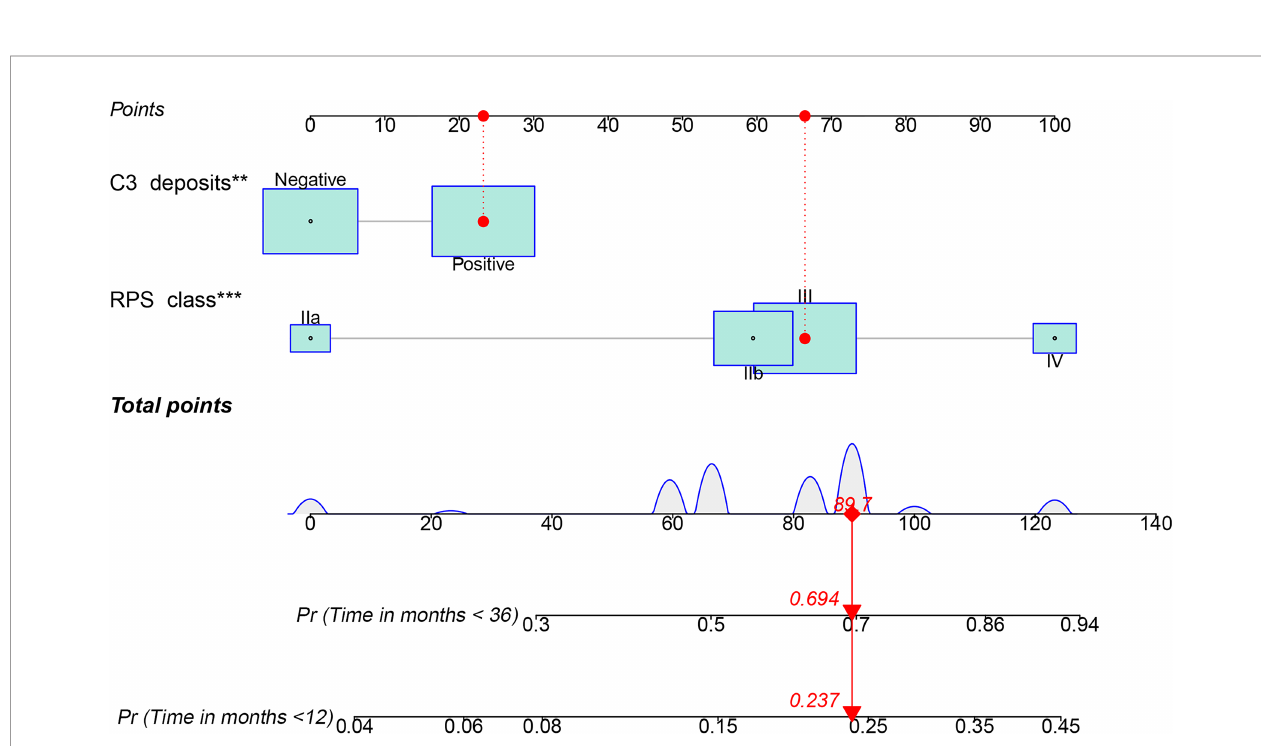
FIGURE 4 | Nomogram predicting the occurrence of a composite of end-stage renal disease, ≥ 50% decline in initial estimated glomerular fi ltration rate, or death according to the combination of C3 deposits and RPS class. PRS, Renal Pathology Society; ** p < 0.01; *** p < 0.001. C3 positive, 23.2 points; IIb, 59.5 points; III, 66.4 points; IV, 100